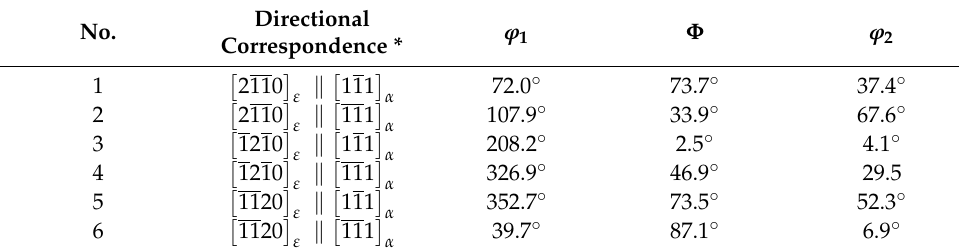
Table 2. Orientations after the ε → α transformation from ( ϕ 1, Φ , ϕ 2 ) ε = (32.5 ◦ , 42.5 ◦ , 5.0 ◦ ). No.